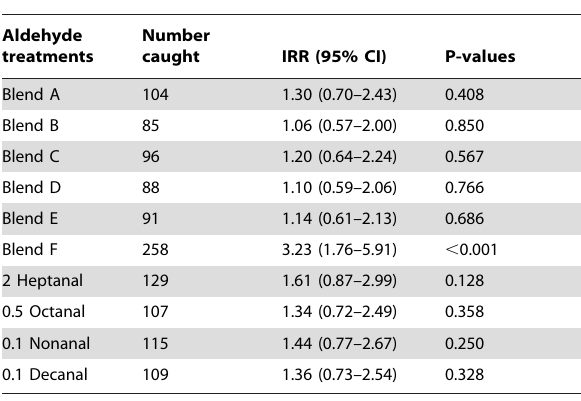
Table 2. Captures of primary RVFV mosquito vectors ( Ae. mcintoshi and Ae. ochraceus ) recorded at different optimal synthetic component doses and a blend in 9 replicate field trials.